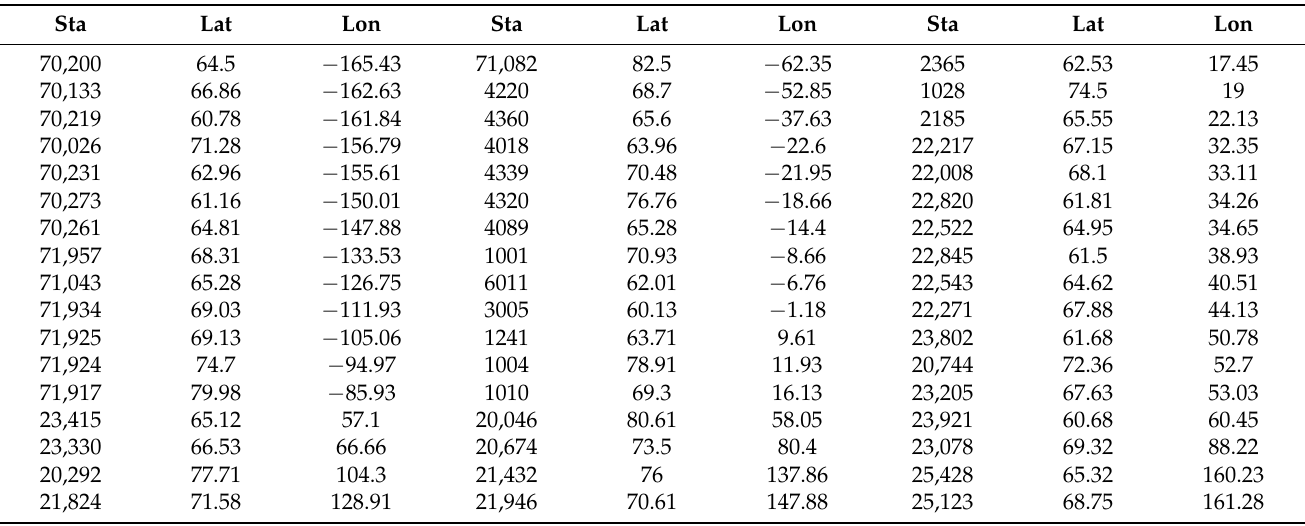
Table 4. Information of 51 radiosonde stations used in this study (Sta represents sounding station number, Lat represents latitude of the station, and Lon represents longitude of the